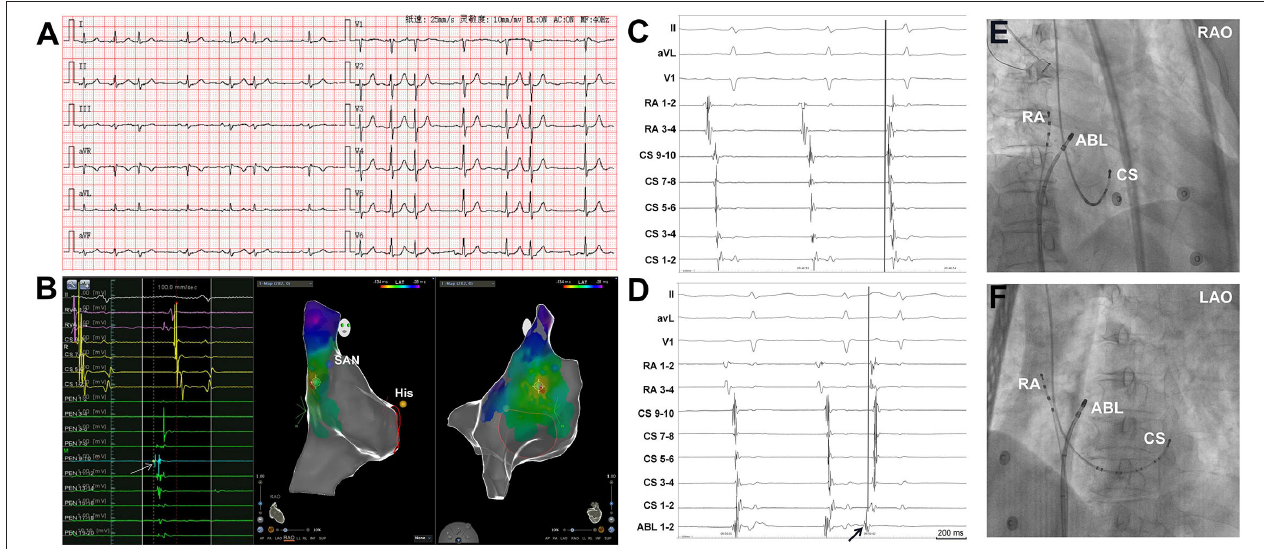
FIGURE 1 | Simultaneous recordings of the right atrium (RA) and coronary sinus (CS) showing the differentiation of spontaneous PACs from PACs induced by catheter manipulation. (A) Surface ECG tracings during spontaneous PACs showing the P-wave morphology. The P-wave morphology in most of the leads is not clearly seen. (B) The 3D mapping shows that the origin site of the PACs is located at the high crista terminalis. The light blue dot indicates the earliest activation point of PACs. The dark blue dot indicates the sinoatrial node. The yellow dot indicates the His bundle. A double sharp atrial potential was recorded in the PentaRay catheter 9-10 (PEN 9-10, the arrow and the light blue dot) and the first atrial potential precedes surface ECG P wave in lead V 1 by 40ms. The RVA channels were connected to the RA catheter. (C) Surface ECG, RA, and CS tracings during spontaneous PAC and PAC induced by mapping catheter manipulation (D) . During spontaneous PAC, the proximal RA activation is earlier than the distal RA activation and the atrial activation sequence in CS is from proximal to distal. The proximal RA activation is earlier than the proximal CS activation. During PAC induced by the mapping catheter manipulation (arrow, the catheter was in high RA), the proximal RA activation is almost simultaneous to the distal RA activation and the distal CS atrial activation is earlier than the proximal CS atrial activation. (E) and (F) Radiographs of RA, CS, and ABL catheters. 3D, three dimensional; ECG, electrocardiogram; PAC, premature atrial contraction; SAN, sinoatrial node; ABL, ablation catheter; LAO, left anterior oblique projection; RAO, right anterior oblique